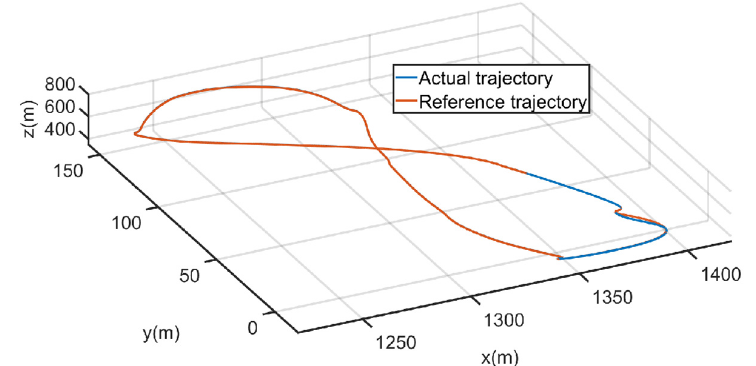
Figure 13. Three-dimensional tracking trajectory.